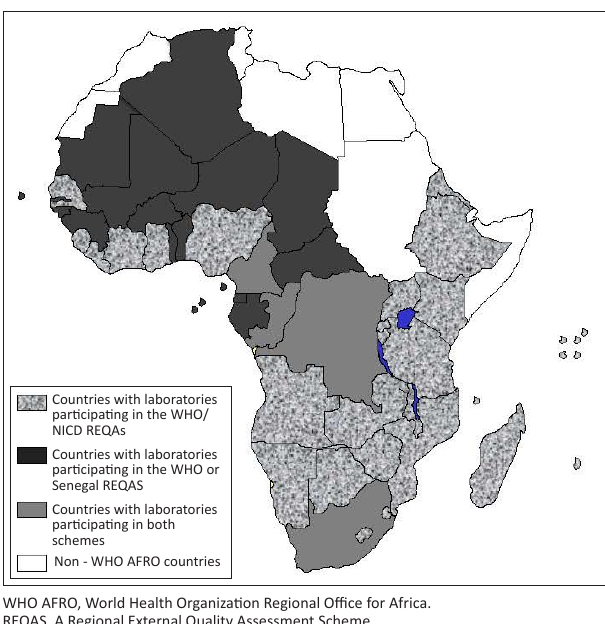
FIGURE 2: Countries currently participating in the WHO/REQAS for anti-HIV